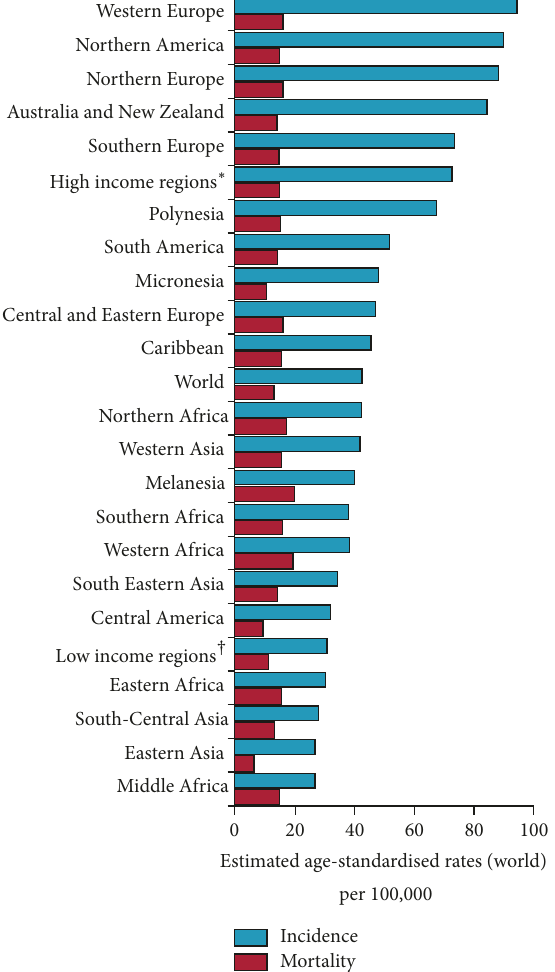
Figure 1: Global breast cancer incidence and mortality in women in 2012. Estimated age-standardised rates for breast cancer incidence (blue bar) and mortality (red bar) in females are shown for global regions, high income regions, low income regions, and the world. Reproduced with permission from Abenaa M Brewster, Mariana Chavez-MacGregor, and Powel Brown. ∗ includes all regions of Europe, Northern America, Australia, New Zealand, and Japan. † includes all regions ofAfrica, Asia (excluding Japan), LatinAmerica, the Caribbean, and Federated States of